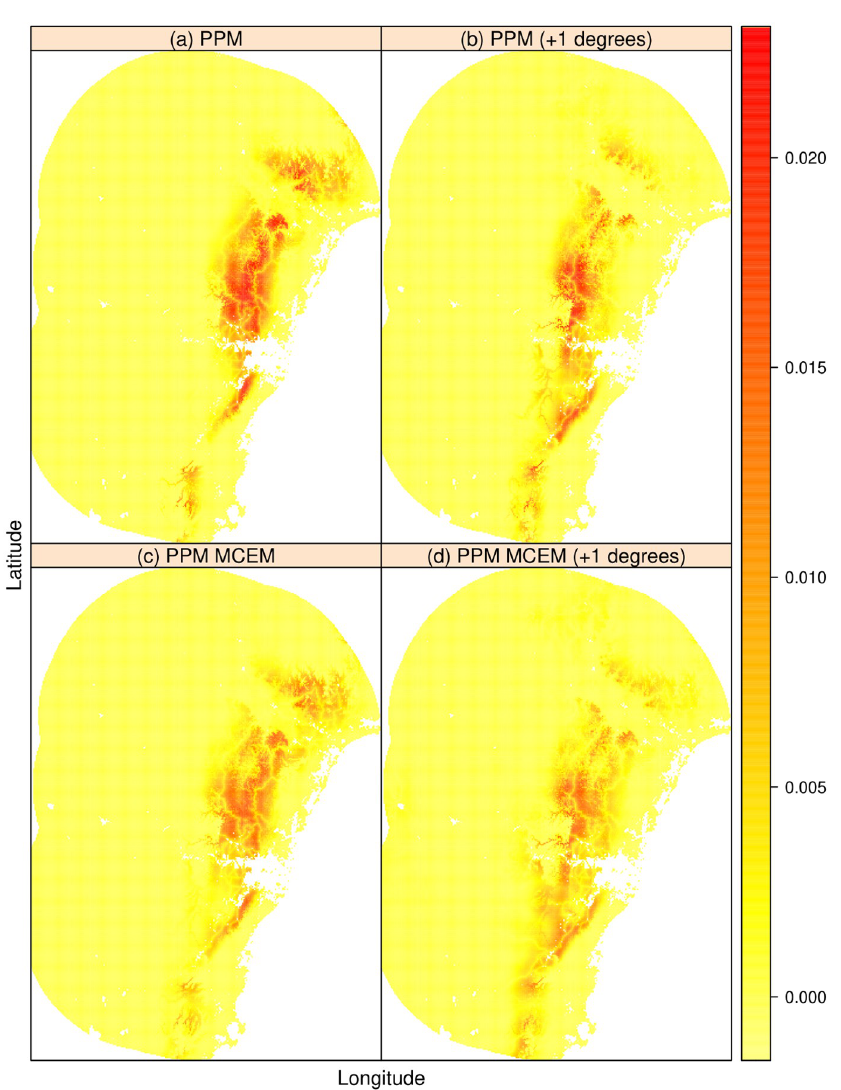
Fig 4. Predicted presences of Corymbia eximia using presence-only data. We assume the temperature covariate is subject to measurement error ( s 2 ¼ 1 or with a reliability ratio of 73%). Models in the top row do not account for u measurement error in the max temperature variable (reliability ratio of 100%) (a) PPM; (b) PPM with a 1.0 degree shift in max temperature; (c) PPM MCEM; and (d) PPM MCEM with a 1.0 degrees Celsius shift in max